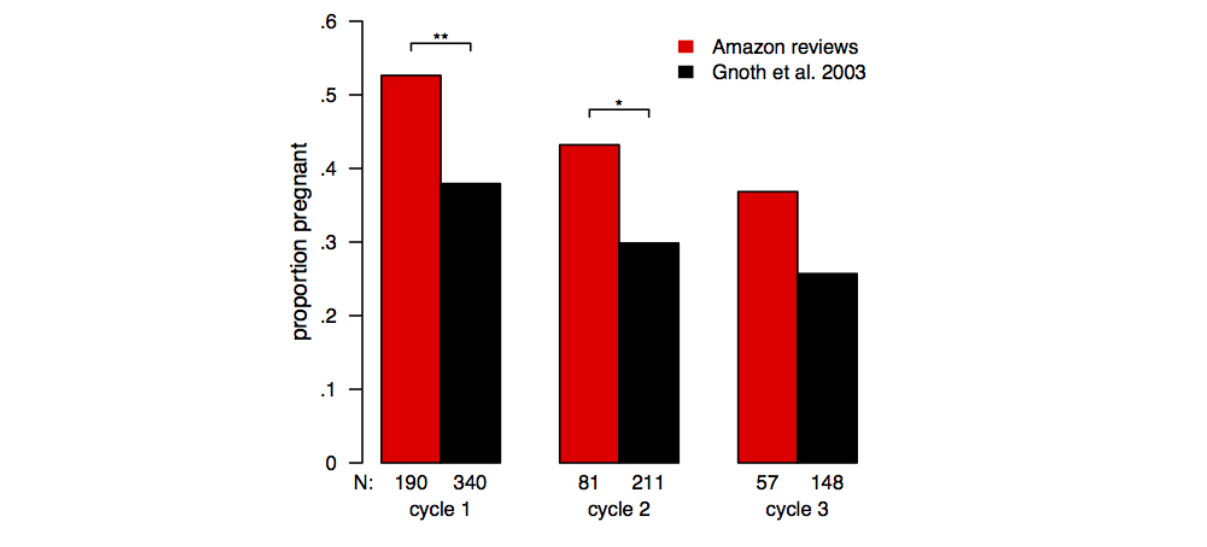
Figure 3. Proportion of non-pregnant women who conceived in each cycle of prospective study and in Amazon reviews of herbal/vitamin fertility treatments. Amazon proportions were calculated by collating reviews in which treatment was used for 28±14 days (cycle 1), 56±14 days (cycle 2), and 84±14 days (cycle 3). 1 star (*) and 2 stars (**) indicate statistically significant differences at P<.05 and P<.01 levels,